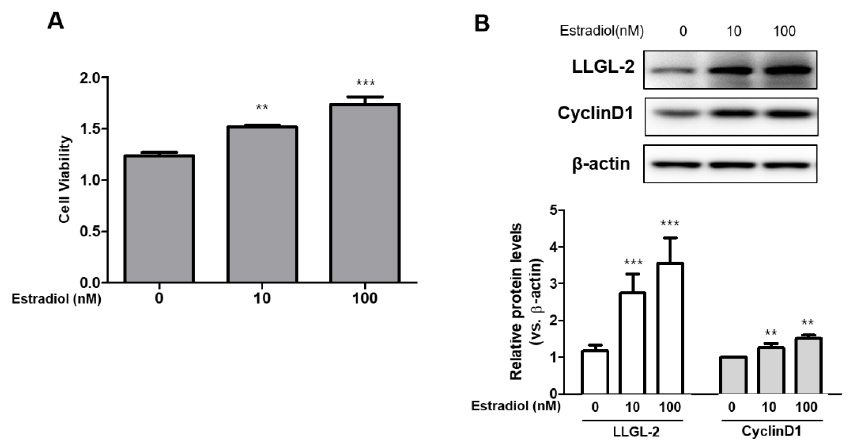
Figure 2. LLGL2 expression and BPH-1 cell proliferation in E2-treated BPH-1 cells. ( A ) E2 treatment (0, 10, and 100 nM) increased viability of BPH-1 cells. ( B ) Western blot data showing up-regulated protein expression of LLGL2 and cyclin D1 after treatment with E2 (0, 10, and 100 nM) for 24 h. Graphical representation of the ratio of LLGL2 and Cyclin D1 to β -actin. Values are expressed as the means ± standard deviation; ** p < 0.01 and *** p < 0.001 versus E0 group.